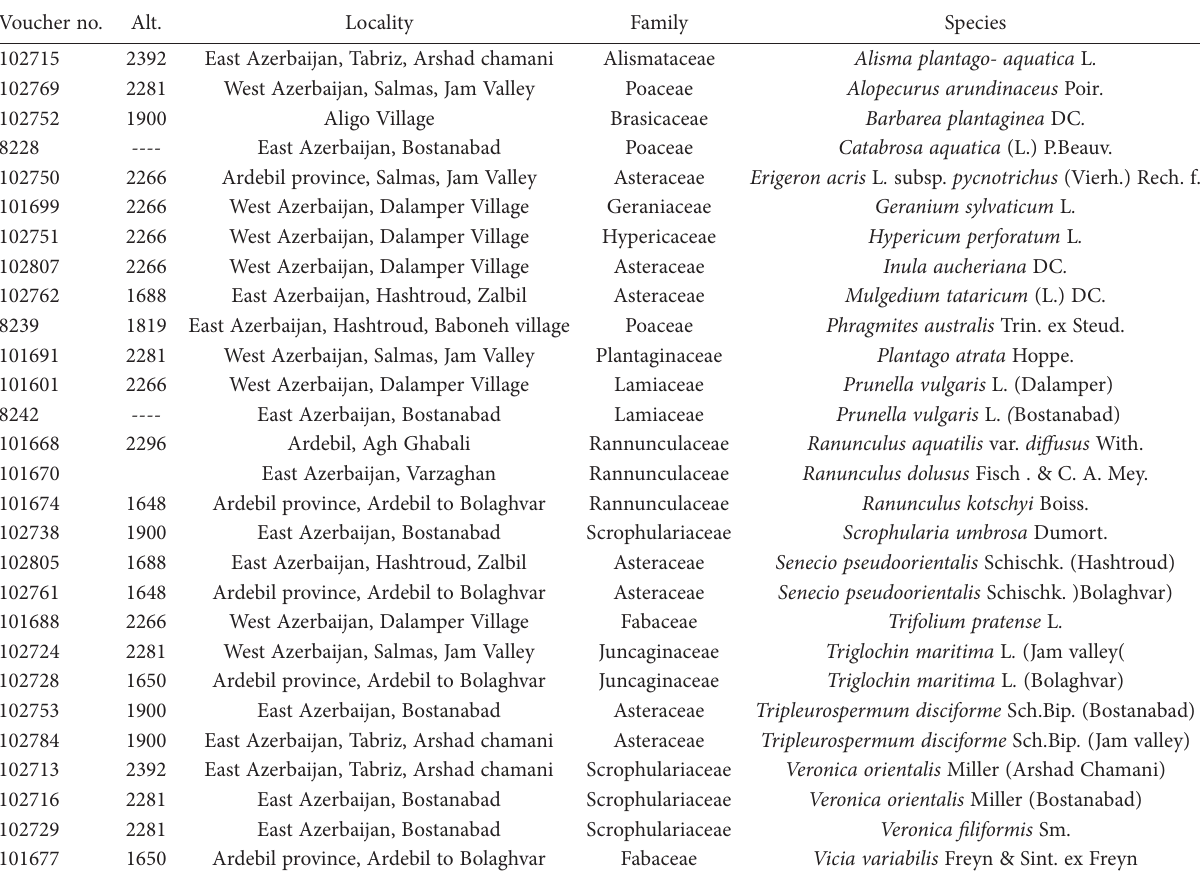
Table 1. List of species examined, Family, Locality, Altitude, Voucher number, and Habitat. Voucher